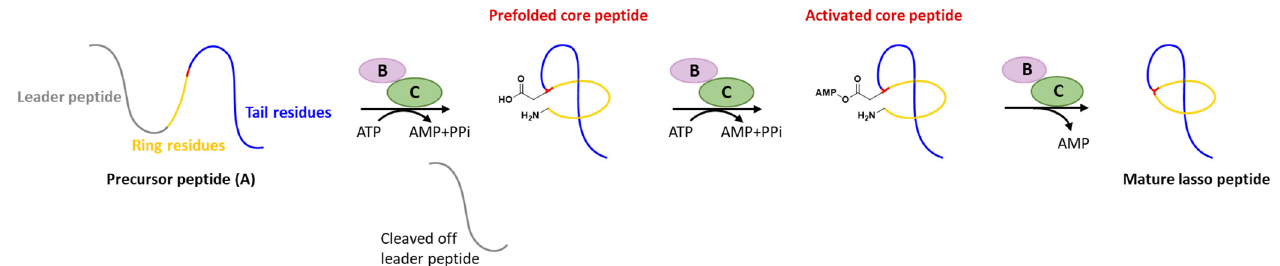
Figure 1. Typical biosynthetic pathway of lasso peptides.